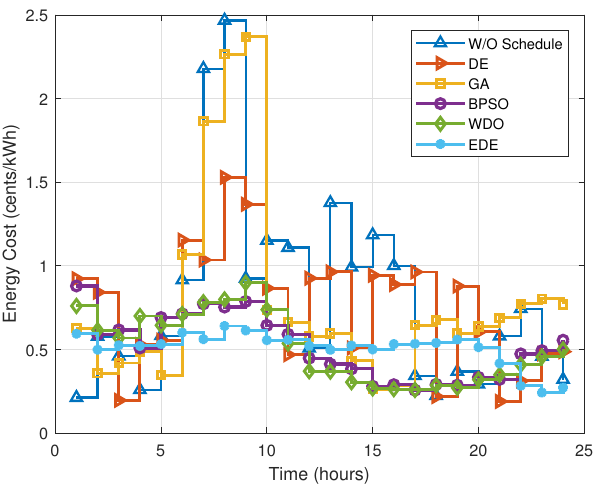
Figure 9. Interruptible appliances energy cost per hour evaluation.